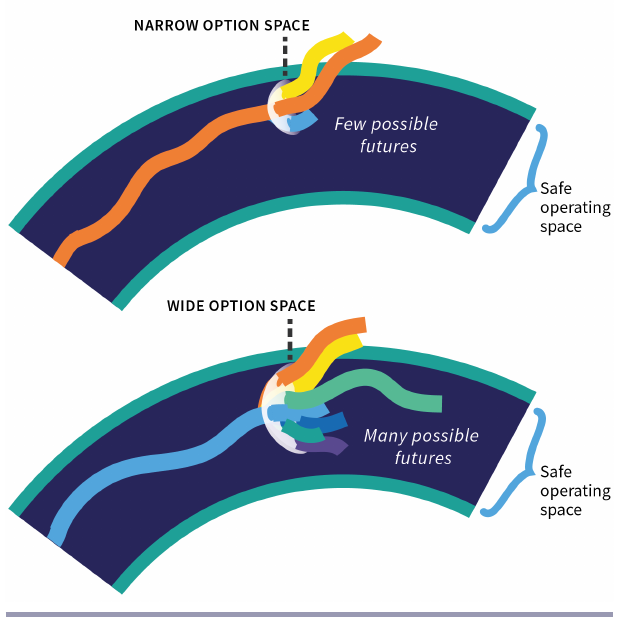
Fig. 3. Comparison of narrow and wide option spaces. While navigating a system toward sustainability through adaptive and transformative change, it is important to maintain option space, i.e., the range of future choices that remain available in a system. Maintaining options will be key to navigating the rapidly changing Anthropocene, where trajectories of development that seem promising today may become undesirable over time, moving the system beyond planetary and social boundaries. Illustration: E.